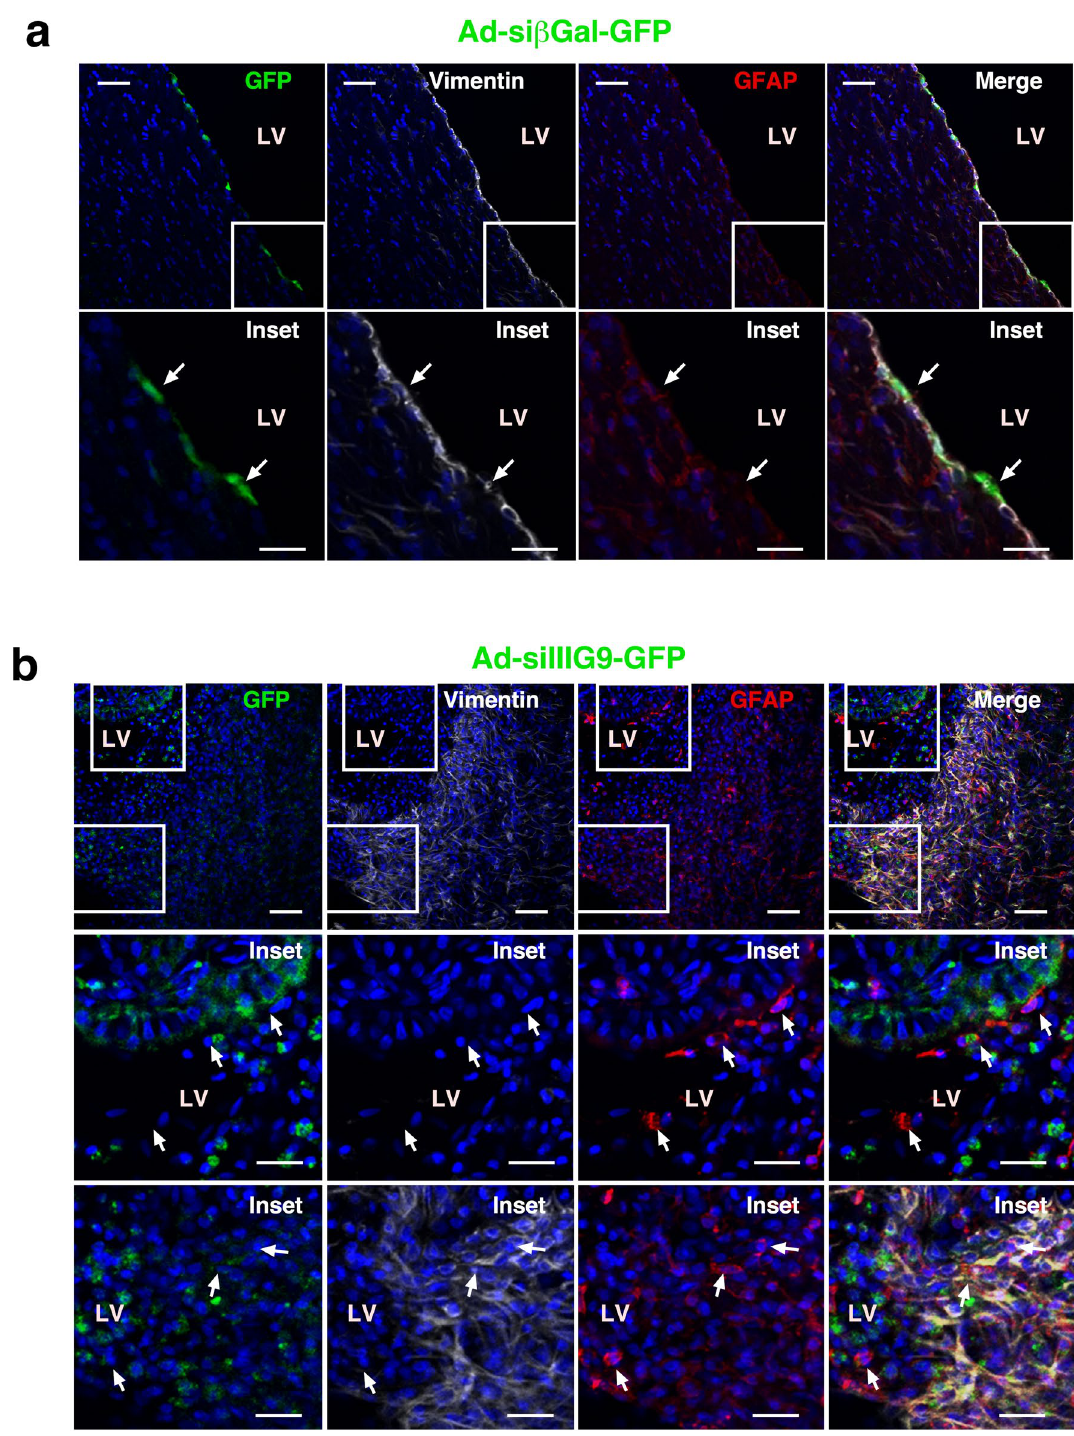
Figure 7. Microglial cell distribution in parenchymal reactive gliosis induced by loss of IIIG9 function. ( a ) Ad-sibGal-GFP expression and immunohistochemistry analysis. GFP, vimentin and IBA-1 detection in ventricular ependymal cells. Diffuse IBA-1 staining was detected below the ependymal cells (arrows in insets). ( b ) Ad-siIIIIG9-GFP expression and immunohistochemistry analysis. GFP, vimentin and IBA-1 were mainly detected in the gliosis area. IBA-1- and GFP-positive cells were also detected in cells inside the ventricular area (inset in upper panel). All images are representative of different biologically independent samples. LV lateral ventricle. ( a , b ) n = 4. Scale bars = ( a , b ) 40